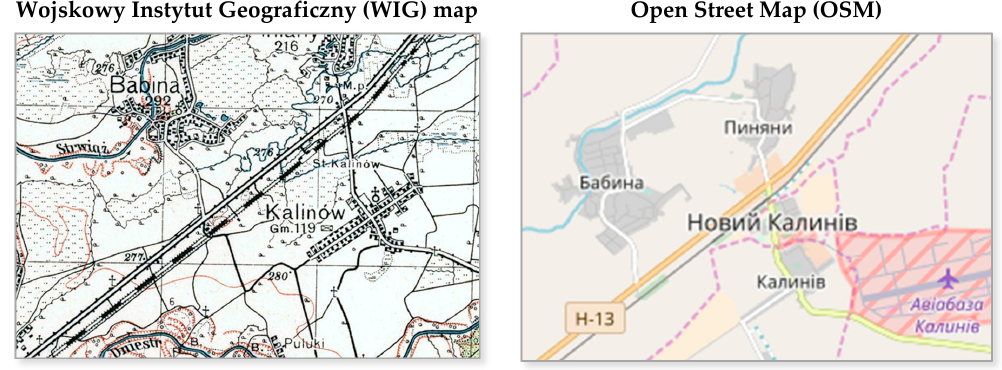
Figure 5. Connection of localities under a new name (source: WIG map, Russian map, and OSM).